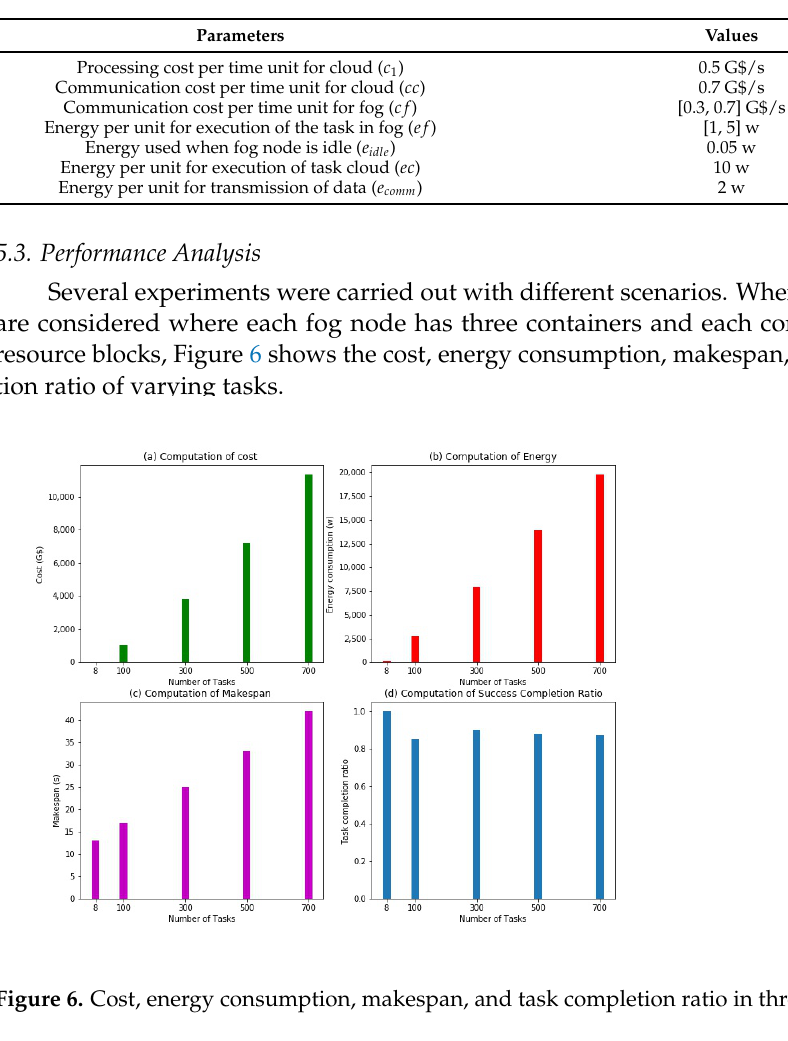
Table 6. Simulation parameters and values setup.